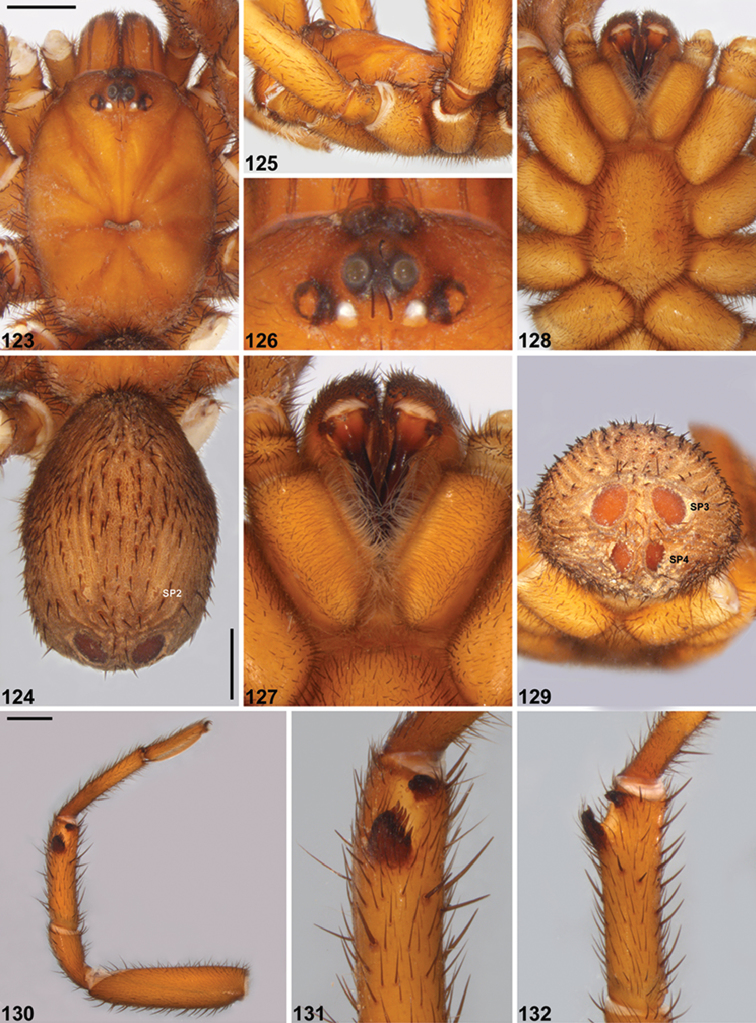

Idiosoma
dandaragan sp. n., male holotype (WAM T139522) from S. of Moora (Western Australia; JAF), somatic morphology. 123–124 Carapace and abdomen, dorsal view 125 Carapace, lateral view 126 Eyes, dorsal view 127 Mouthparts, ventral view 128 Sternum, ventral view 129 Abdomen, posterior view 130 Leg I, prolateral view 131 Leg I tibia, clasping spurs, prolateral view 132 Leg I tibia, proventral view. Scale bars 2.0. SP2–4 = sigilla pairs 2–4.